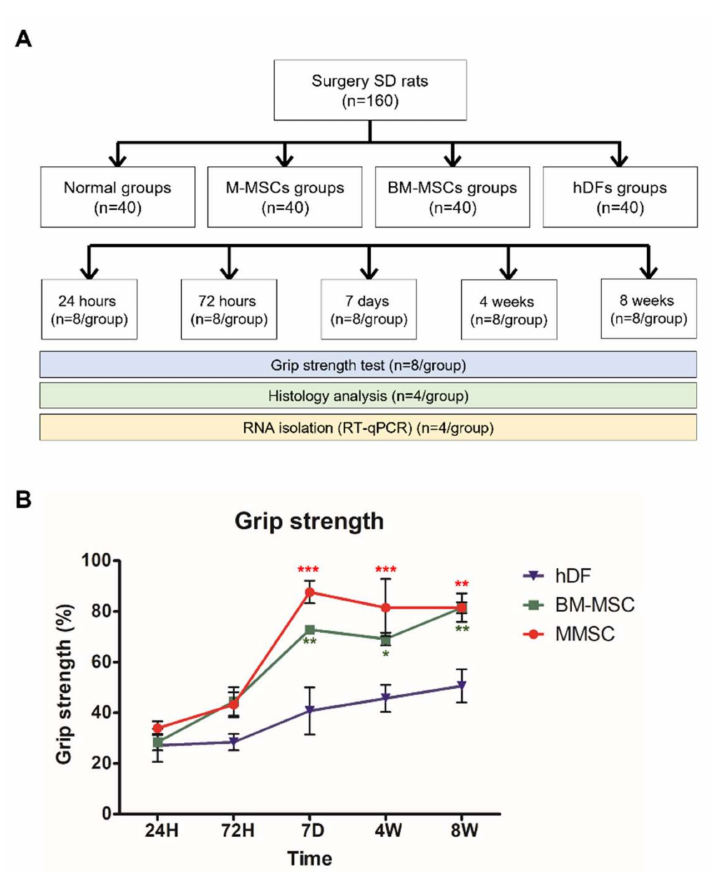
Figure 2. Schematic diagram of the study, effects of MSC injection on grip strength recovery after RCT induction. ( A ) Schematic diagram of the study. Seven-week-old SD rats were randomly divided into 20 groups, and cell injection was operated on the right shoulder. At 5 times, 8 mice per group were sampled and used for the experiment. ( B ) M-MSCs, BM-MSCs, or control hDFs were injected to RCT model rats. At 24 h, 72 h, 7 days, 4 weeks, and 8 weeks after RCT induction, the grip strength tests were conducted for each rat. The data are shown as mean ± SD and the significance was